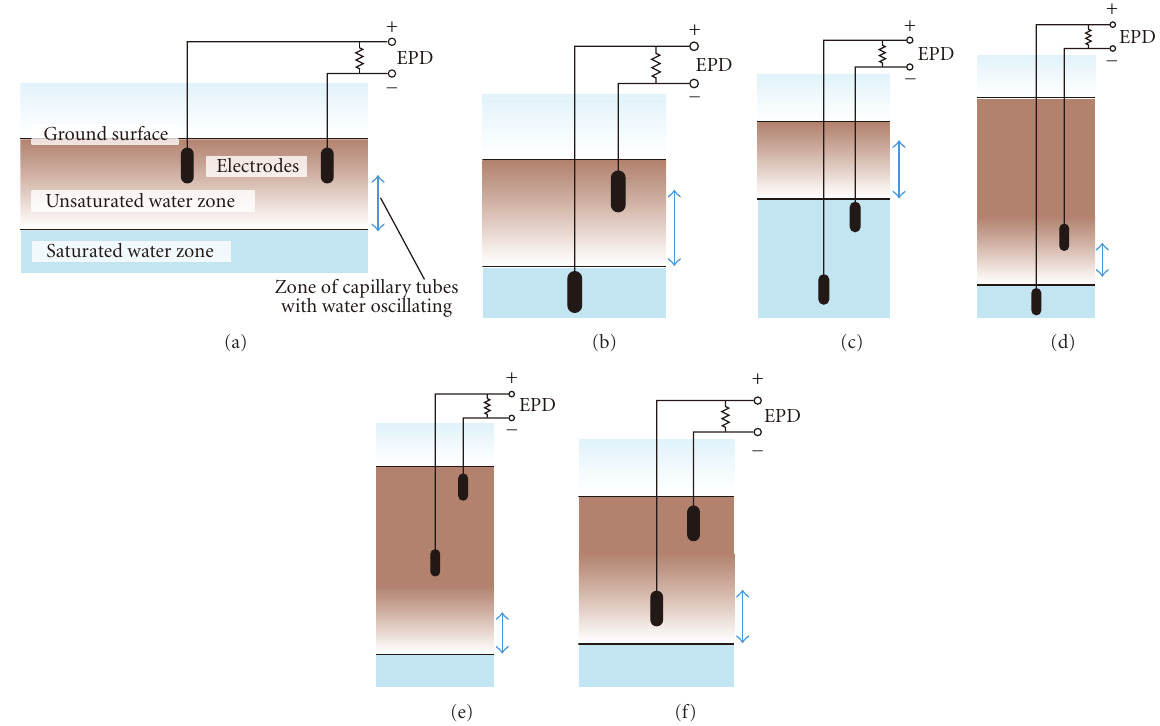
Figure 7: Various cases of locations with the electrode pair buried and with saturated/unsaturated water zone levels. (a) Both electrodes are mutually parallel in the unsaturated water zone. (b) One electrode is buried in the unsaturated water zone; another is buried in the saturated water zone. (c) Both electrodes are buried in the saturated water zone. (d) One electrode is deeply buried in the unsaturated water zone; another is buried deeply in the saturated water zone. (e) Both electrodes are buried in the unsaturated water zone far from the deep saturated water zone. (f) One electrode is buried in the unsaturated water zone; another is buried near but above the saturated water